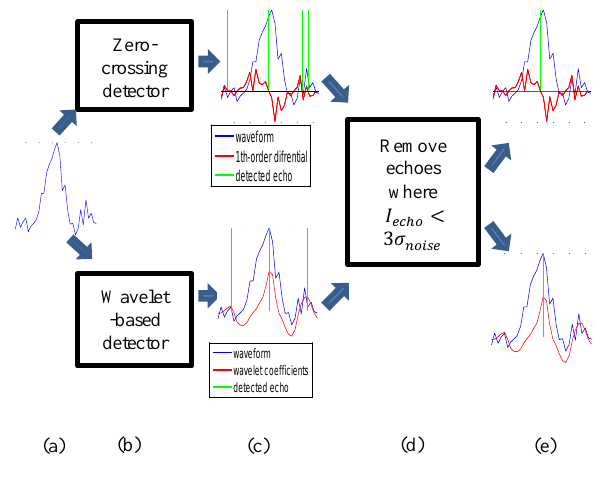
Figure 4. Flow chart of echo detection